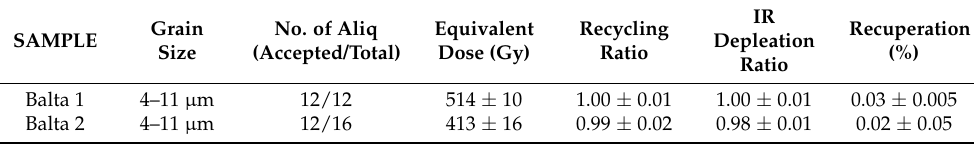
Table A2. Equivalent dose measurement results. The net CW-OSL signal was determined from